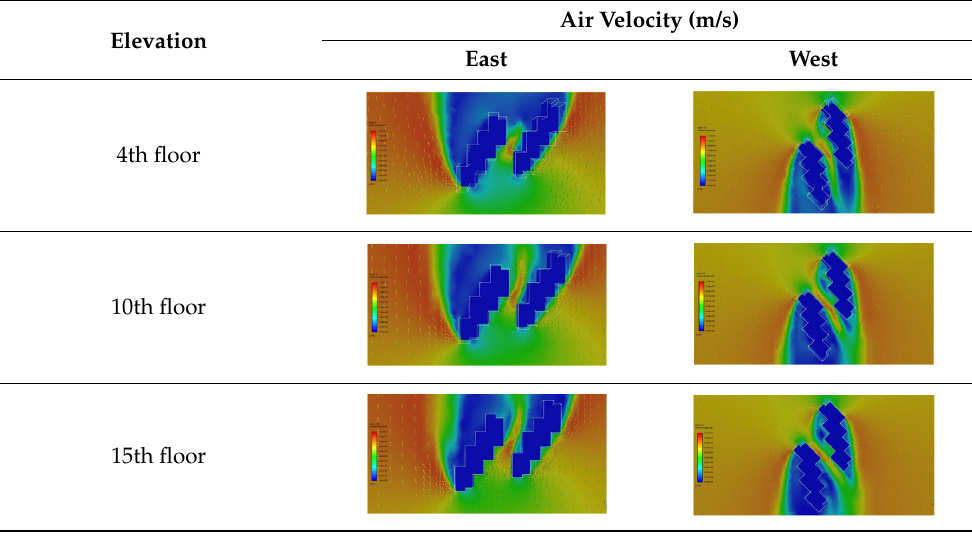
Table 5. Regional simulation results.